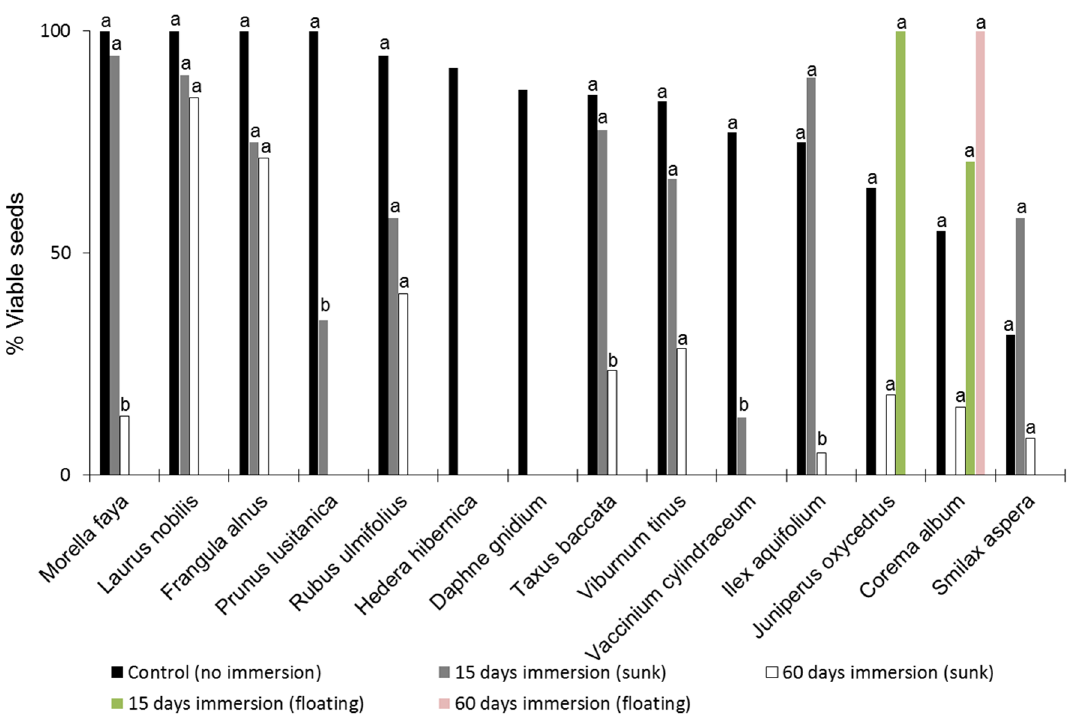
Fig 3. Percentage of viable embryos according to the tetrazolium (TTC) staining test. Embryos were tested under three treatments: control (no immersion), after moderate (15 days) and prolonged (60 days) immersion in saltwater. Different letters indicate significant differences between treatments and the control (G tests, α = 0.05), similar letters reflect no significant differences.